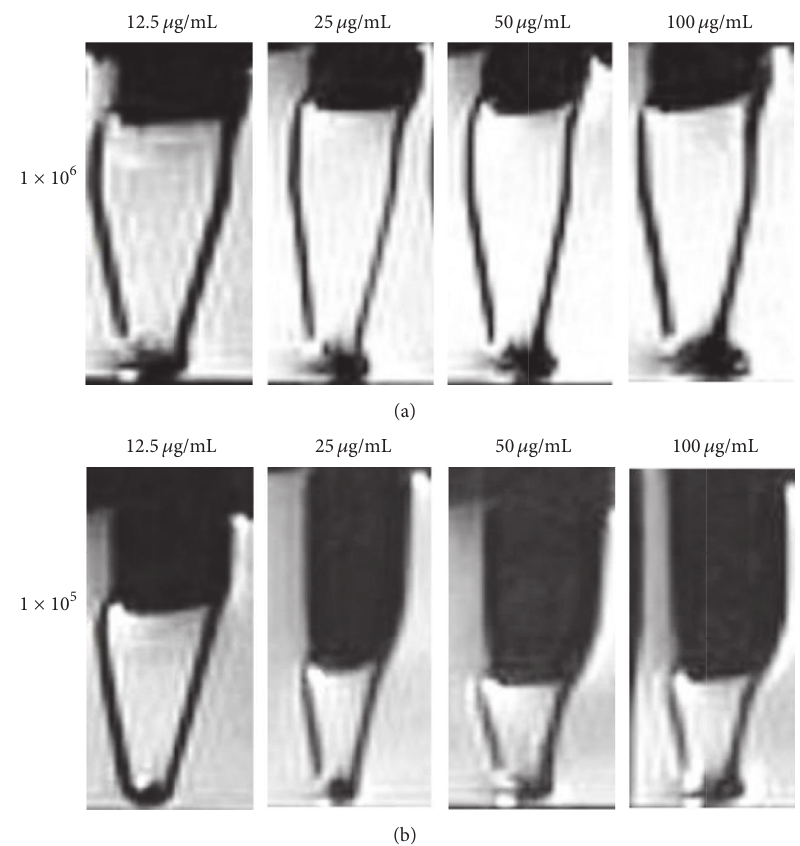
Figure 6: MRI of MIRB-labeled hDPSCs in vitro. (a) MRI of 1 × 10 6 cells labeled with various concentrations of MIRB. (b) MRI of 1 × 10 5